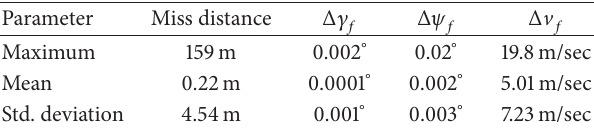
Table 1: Nominal profile and B´ezier parameters.